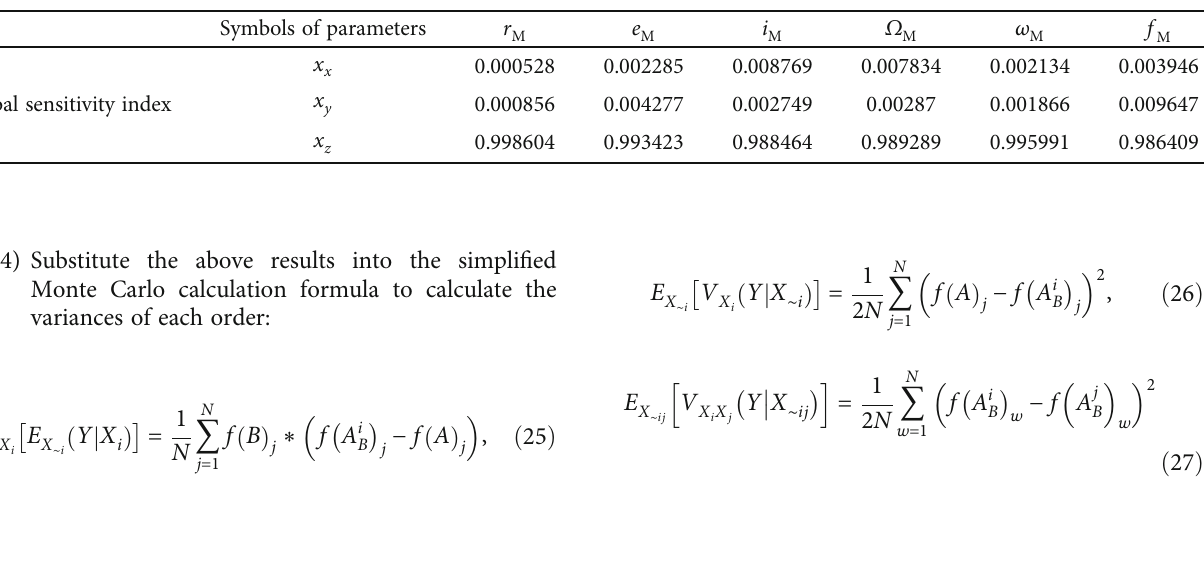
Table 4: Sensitivity index of position